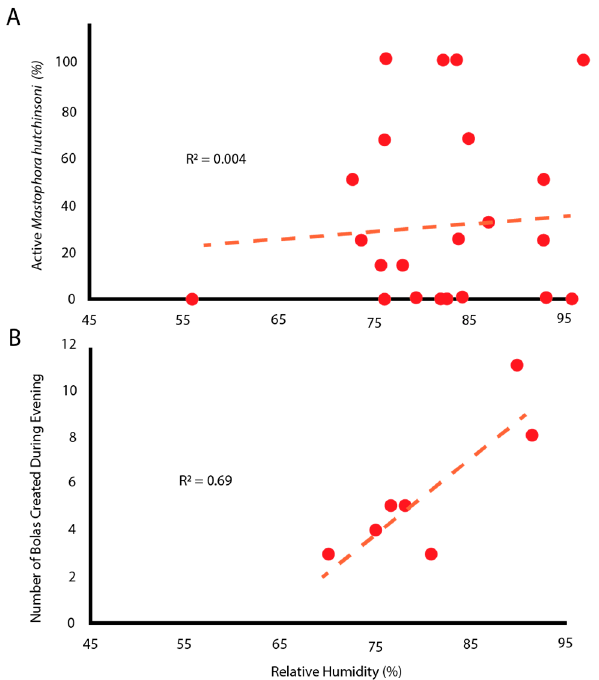
Figure 2. Humidity influenced the making of bolases but not the proportion of spiders who were active. ( A ) Relative humidity did not predict the proportion of spiders that were active. Each point represents observations of multiple spiders on a single tree during a single observation session. ( B ) Relative humidity correlates positively with the number of bolases created. Each point represents all observations on a given day.